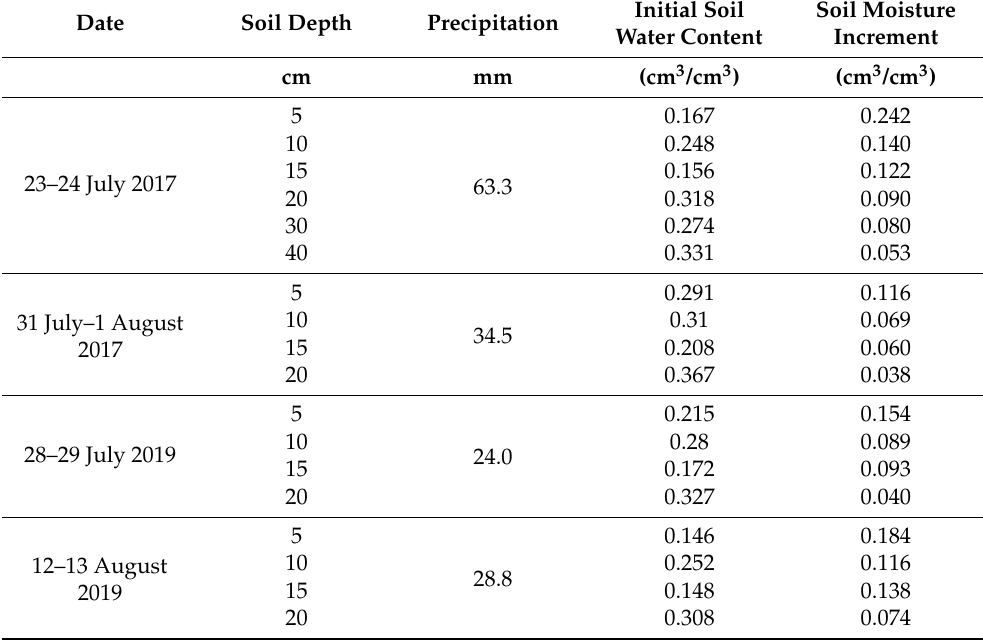
Table 1. Response of soil moisture content to rainfall during a single rainfall event.